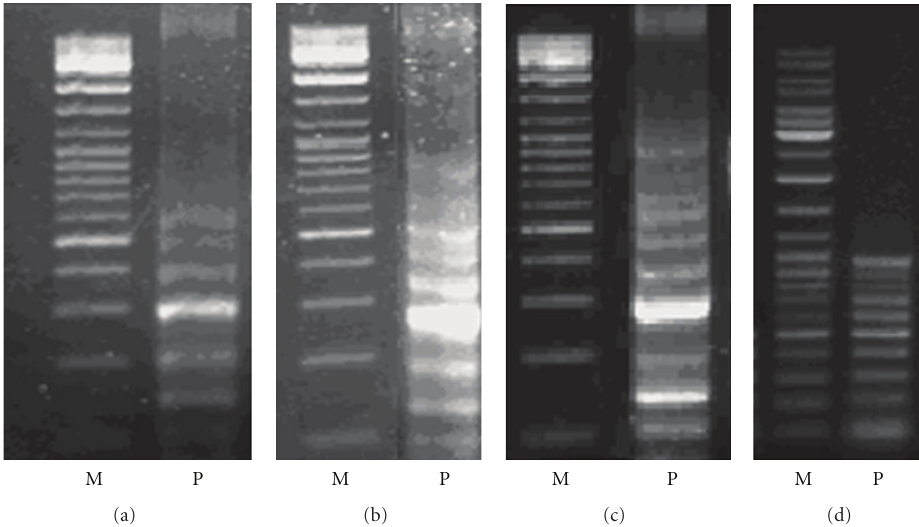
Figure 1: Illustrations of the PCR products for adjusting reaction system and temperature profile. 100–1000 bp fragments were amplified by multiplex PCR using 10 primer pairs in a PCR tube which have the same sense primer. (a) the annealing temperature profile from 58 ◦ C to 48 ◦ C for 30 cycles; (b) 100–500 bp fragments were amplified under the annealing temperature profile from 58 ◦ C to 46 ◦ C for 35 cycles. (c) Adjusting the amount of the ten anti-sense primers and the annealing temperature profile from 56 ◦ C to 46 ◦ C, most of target fragments were detected; (d) Raising the amount of 600–700 bp anti-sense primers and using the annealing temperature profile from 56 ◦ C to 44 ◦ C, all the target fragments were amplified and nonspecific fragments